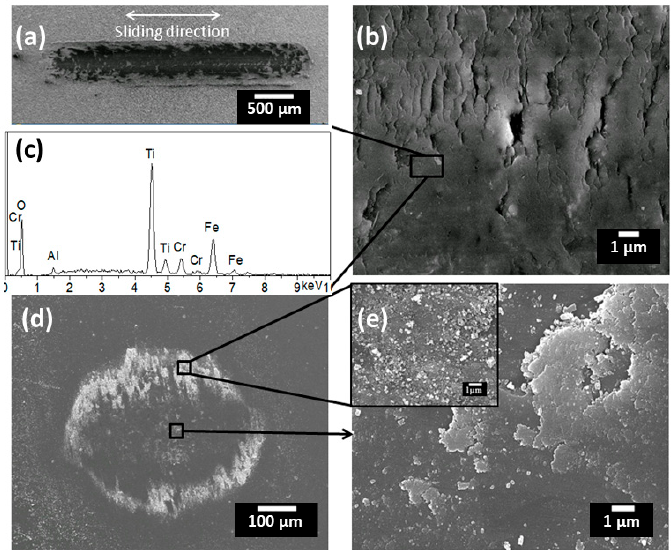
Figure 12. Wear track of coating S3 under ( a ) low magnification and ( b ) high magnification; ( c ) EDS analysis of area in image ( b ); wear scar of counterpart Al 2 O 3 pin under ( d ) low magnification and ( e ) high magnification.